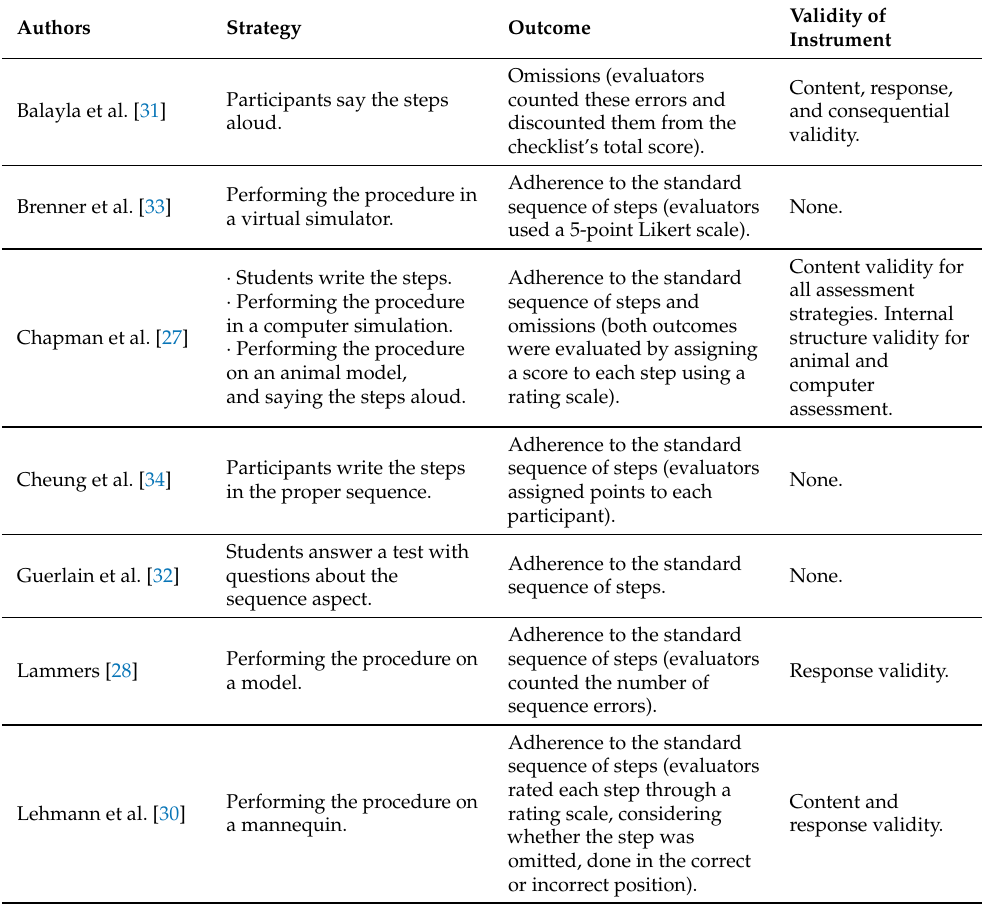
Table 2. Assessing the learning of the sequence of steps: strategy, outcomes, and validity of